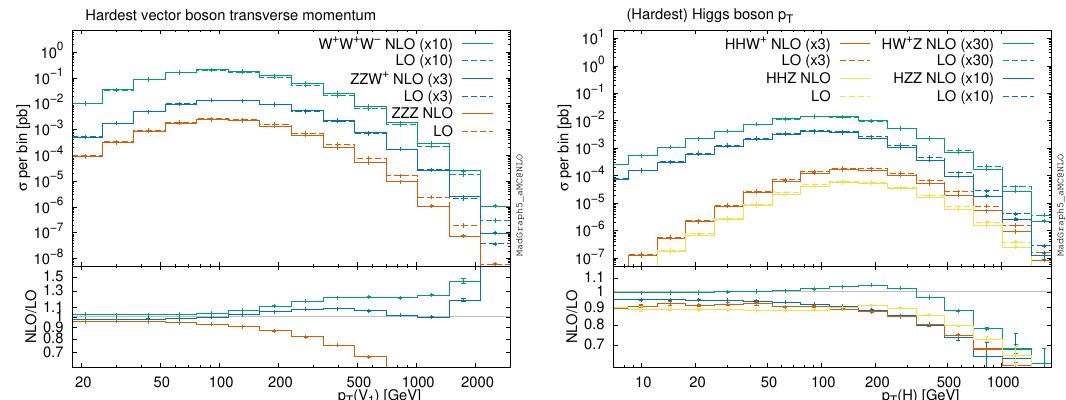
Figure 8. Transverse momentum of the hardest vector boson in the processes of eq. (6.19) (left panel), and transverse momentum of the Higgs boson in the processes of eq. (6.20) (right panel). Some of the histograms in the main frames are rescaled as indicated in order to enhance their